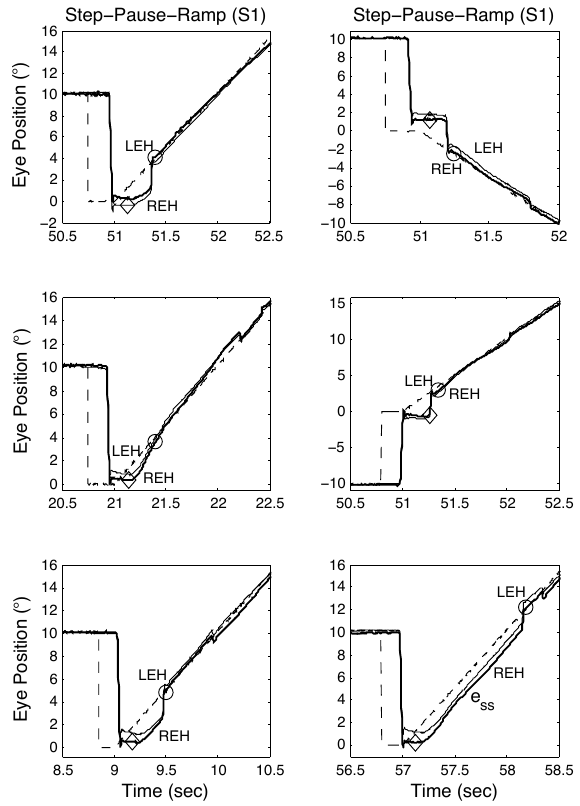
Figure 5. Examples of SPR responses containing proximal saccades from S1 demonstrating both classical and other types of response, including those containing disconjugate saccades. See text for